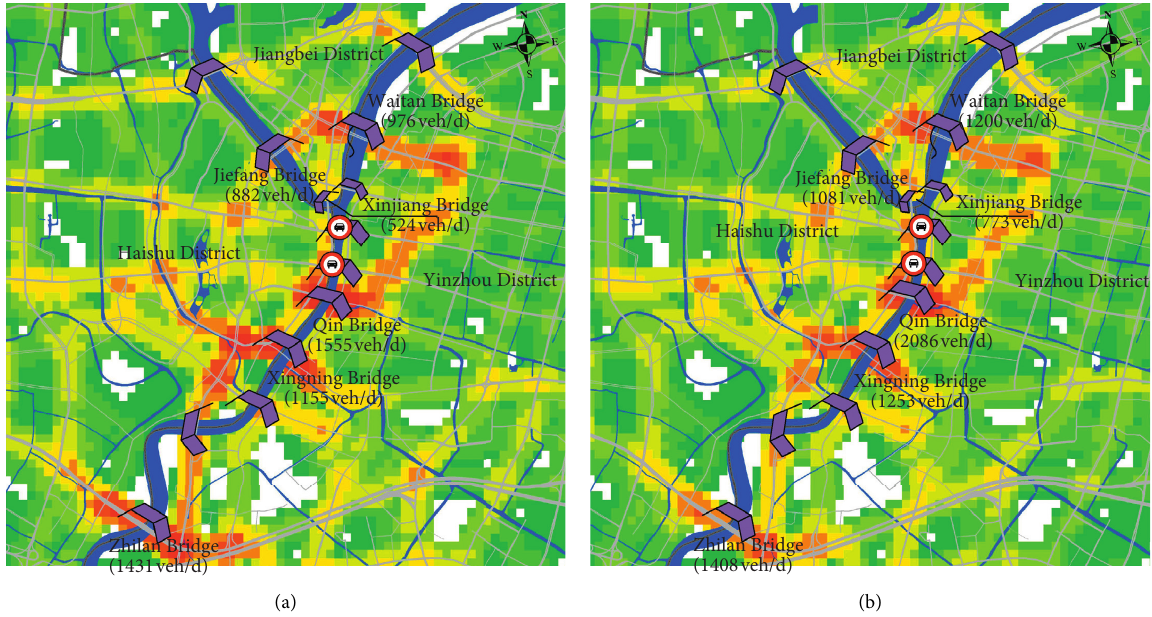
Figure 4: Heat maps of the detours. (a) Trajectory of vehicles with odd number on even days. (b) Trajectory of vehicles with even number on odd days.